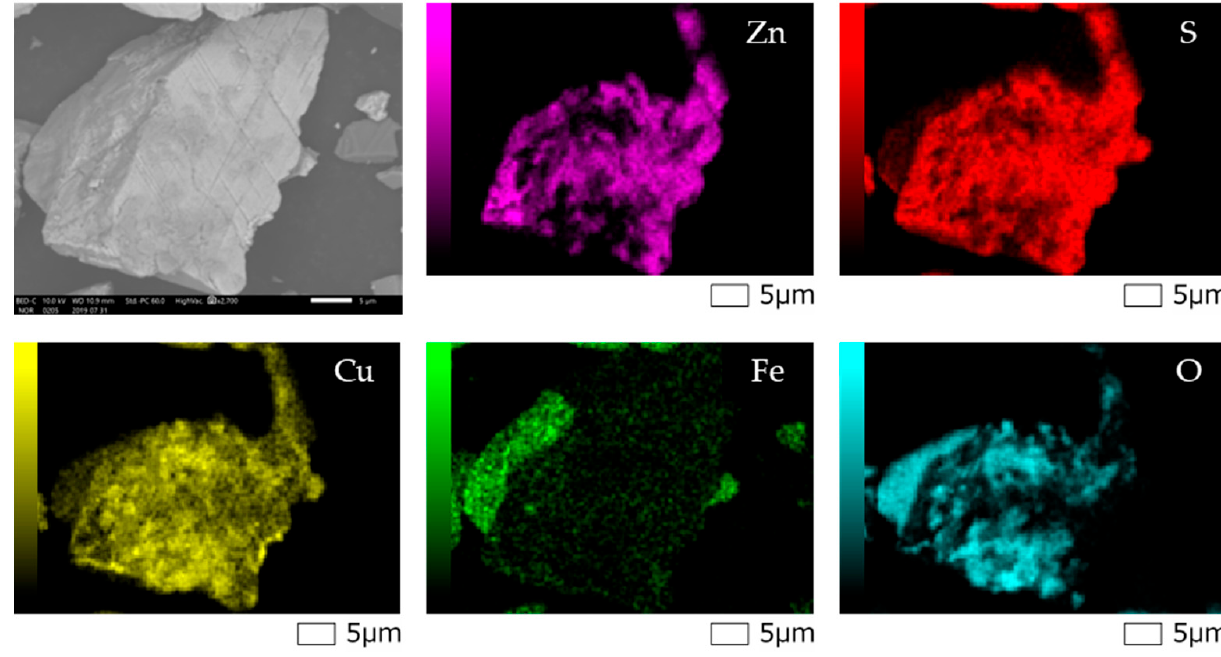
Figure 5. SEM photomicrograph of sphalerite after conditioning with chalcopyrite in the flotation cell with the corresponding elemental maps of Zn, S, Cu, Fe, and O.